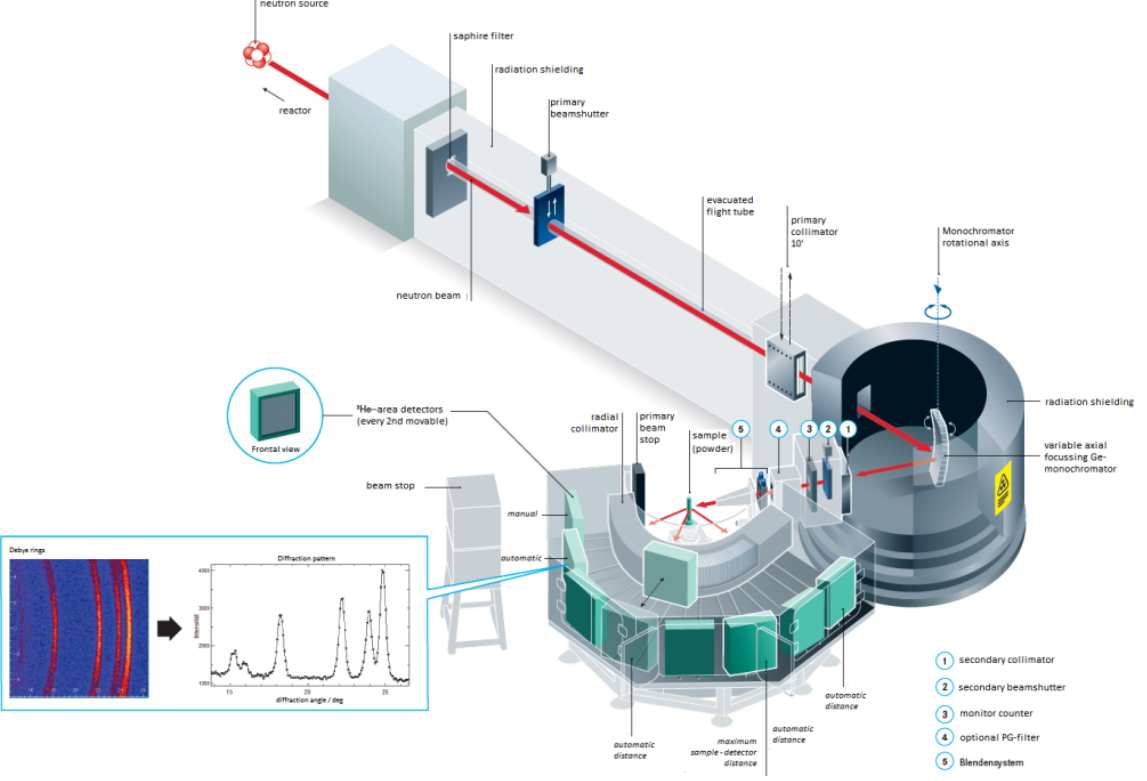
Figure 2: Schematic drawing of